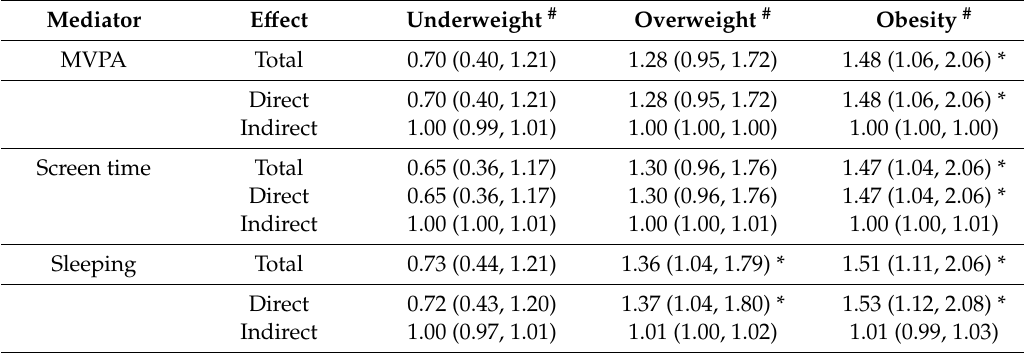
Table 4. Lifestyle factors as mediators in the association between physician-diagnosed asthma and weight